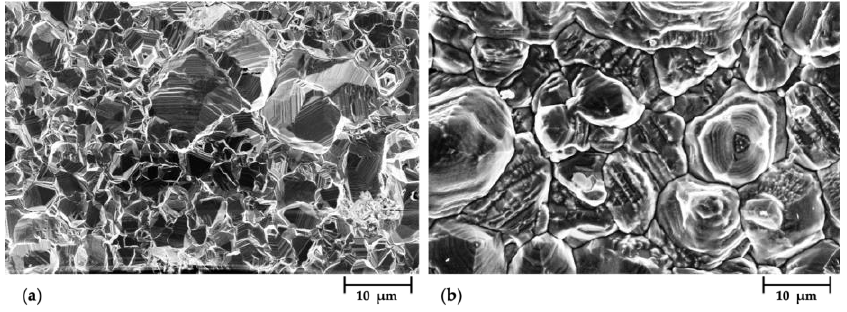
Figure 10. SEM images of CdTe film morphology ( a ) before, and ( b ) after chlorine-treatment with Ar + HCl + fluorine-containing gas (R-23).